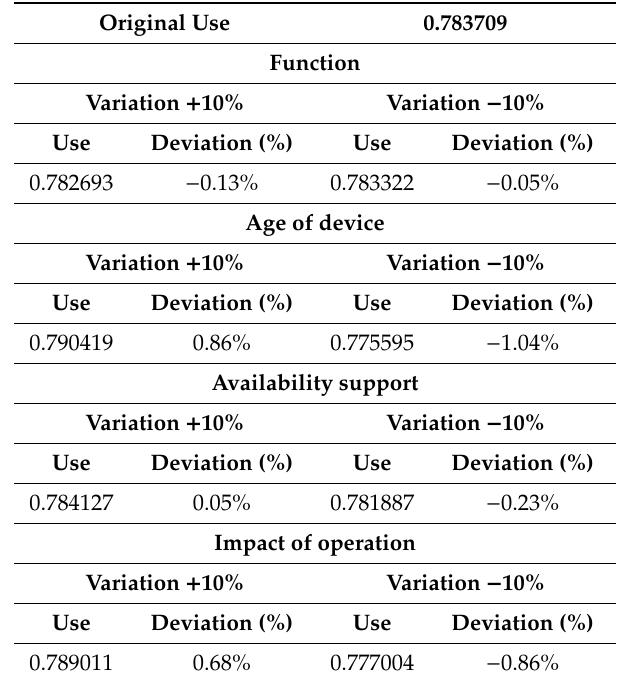
Table 30. Sensitivity analysis for